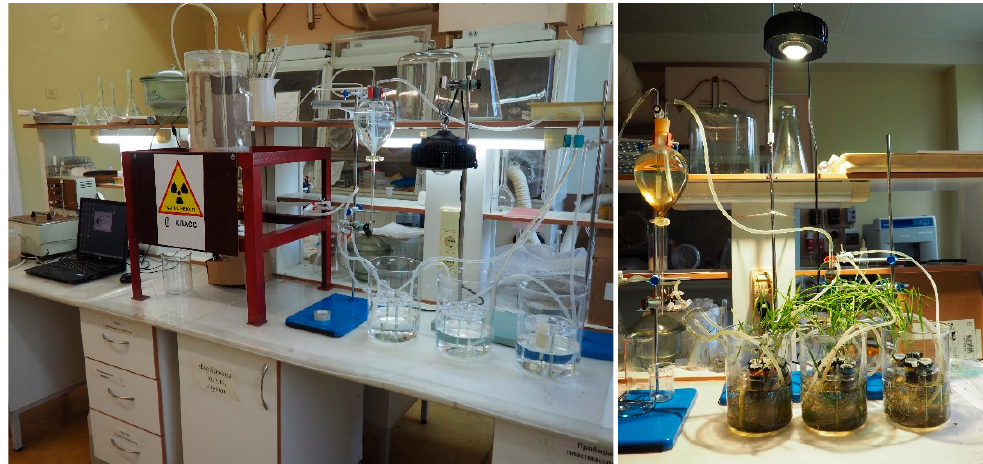
Figure A1. A stand for studying the parameters of 65 Zn(Zn) migration in the soil–soil solution–plant system: 1—the moment of equilibration of deionized water in the system with Albic Retisol (Loamic, Ochric) soil; 2—vegetative vessels with plants.